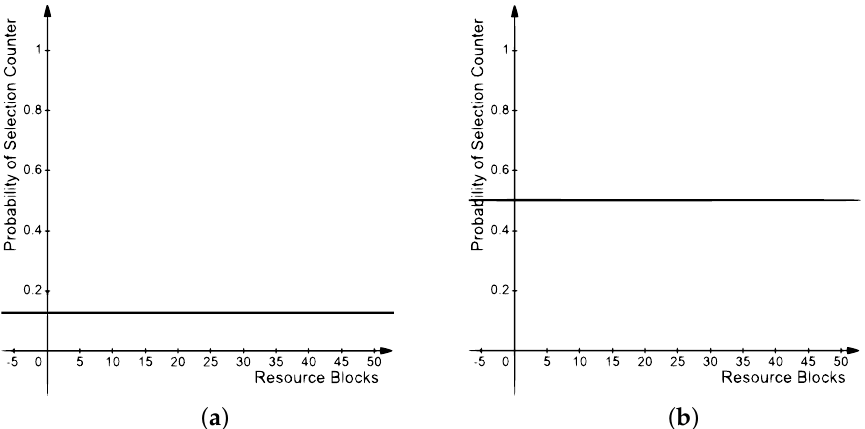
Figure 10. Probabilities of the proposed selection counter; ( a ) For R s = 0.4, ( b ) For R s =